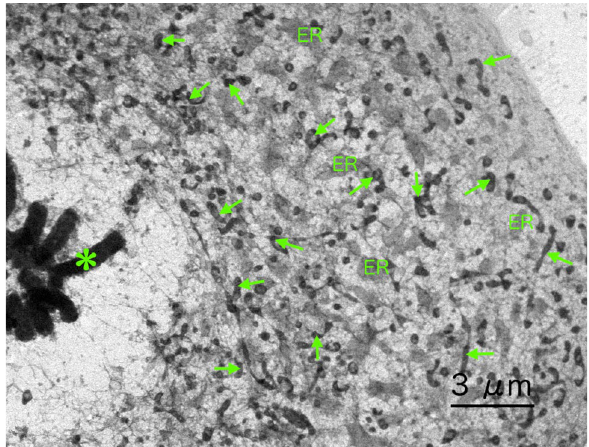
Figure 8. Cryo-electron micrograph of micro-unroofed cells in mitotic telophase. The arrows indicate mitochondria. ER indicates the endoplasmic reticulum. The asterisk shows chromosomes in telophase. Large networks of the ER were preserved well even in mitotic phase despite the disappearance of the nuclear